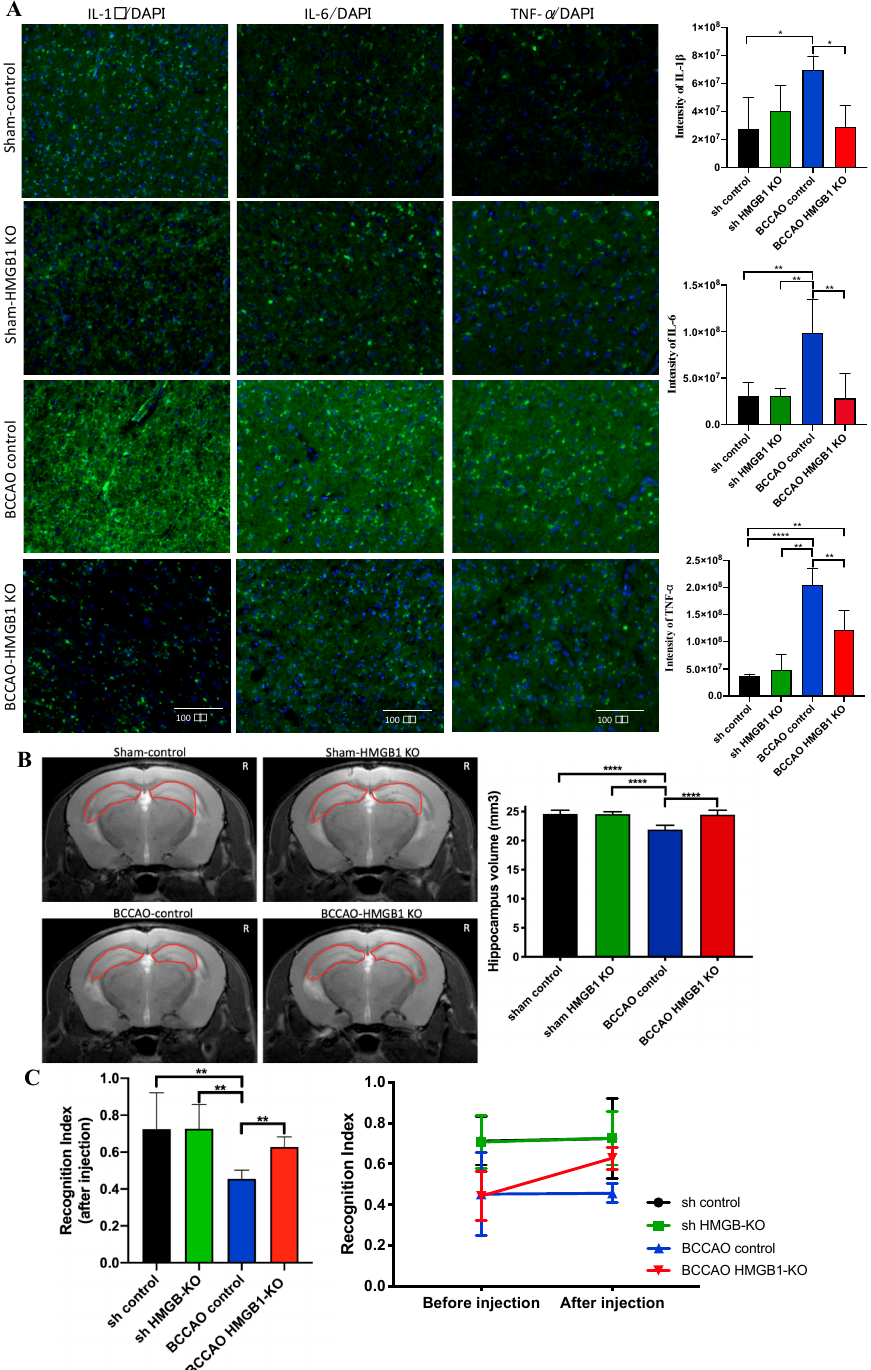
Figure 5. The e ff ect of high-mobility group box protein 1 (HMGB1) suppression with CRISPR / Cas9 knockout (KO) plasmid on proinflammatory cytokines, hippocampus volume, and memory function. ( A ) Decreased level of tumor necrosis factor-alpha, interleukin (IL)-1 β , and IL-6 of bilateral common carotid artery occlusion (BCCAO) HMGB1-KO mice showed with immunostaining. ( B ) Attenuation of hippocampal atrophy in BCCAO HMGB1-KO mice but not in BCCAO controls (the area of the hippocampusisindicatedwitharedcircle). ( C )ImprovementofmemorydeclineinBCCAOHMGB1-KO mice but not in BCCAO controls. n = 5 for each group. Data are presented as the mean + standard deviation; * p < 0.05; ** p < 0.01; *** p < 0.001 with one-way analysis of variance (ANOVA) followed by Sidak’s multiple comparison test; novel object recognition test before and after CRISPR / Cas9 injection with two-way ANOVA (F(3,24) = 7.598, p < 0.01); scale bar = 100 µ